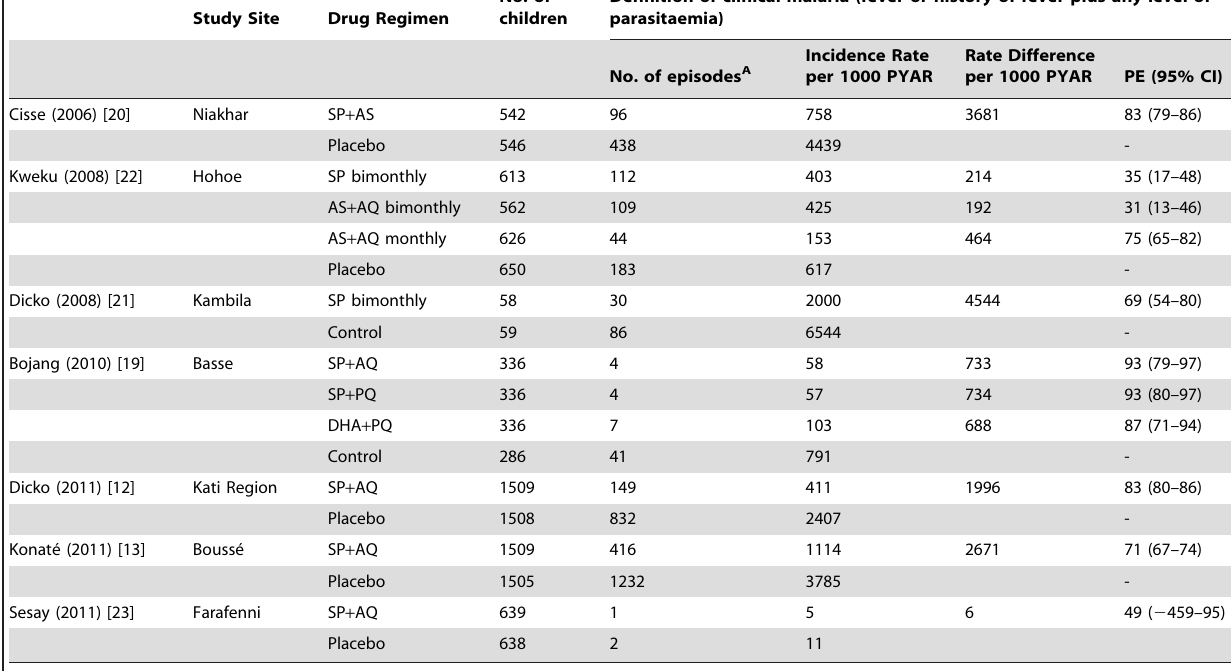
Table 4. Effect of IPTc on clinical malaria during the intervention period.